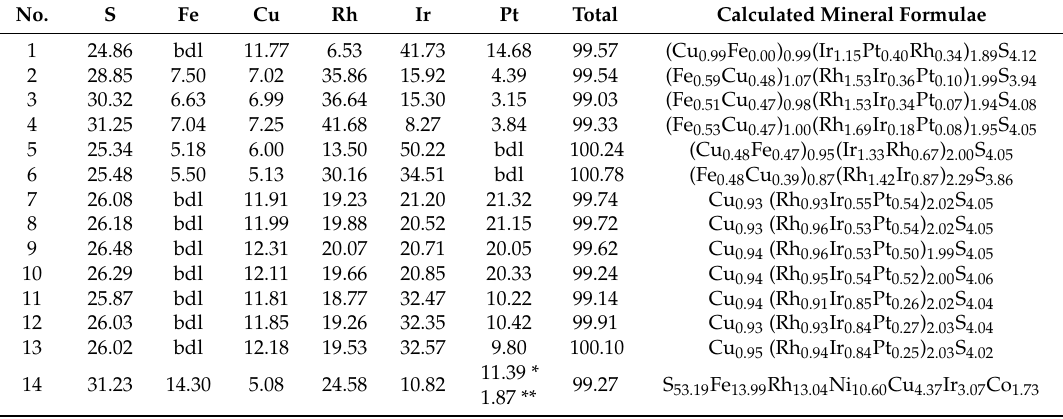
Figure 13. BSE images (SEM) of Pt-Ir-Rh thiospinels from the Vershinniy eluvial ( a ), the Travyanistyi proximal ( b ) and the Glubokinskoe distal placers ( c ). The number of points corresponds to the data in Table 6 for thiospinels (No. 4, 5, 8–10) and Table 5 for kashinite (No. 24, 25). Isf—isoferroplatinum, Erl—erlichmanite, Os—osmium, CuIrst—cuproiridsite, FeRhst—ferrorhodsite, and CuRhst—cuprorhodsite. Table 6. Composition of Ir-Rh-Pt thiospinels from the chromite-platinum ore zones of the Svetloborsky massif (1–4), the Vershinniy eluvial placer (5–6), the Travyanistyi proximal placer (7–10), and the Glubokinskoe distal placer (11–13).